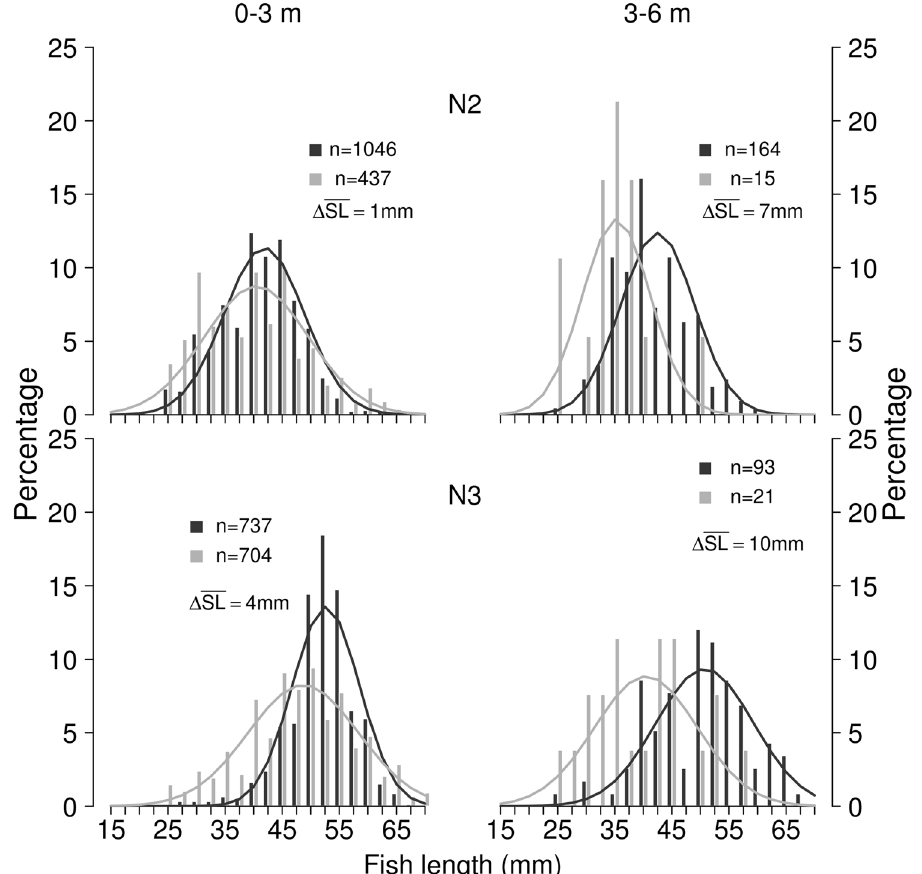
Figure 2. Length frequency distribution of fish from 120 kHz echo sounder and trawling. Numbers of fish in the trawl catches (black) and tracked fish in the 120 kHz acoustic records (grey) are provided for each night and each depth layer. Δ TL stands for the difference between average acoustic and trawl